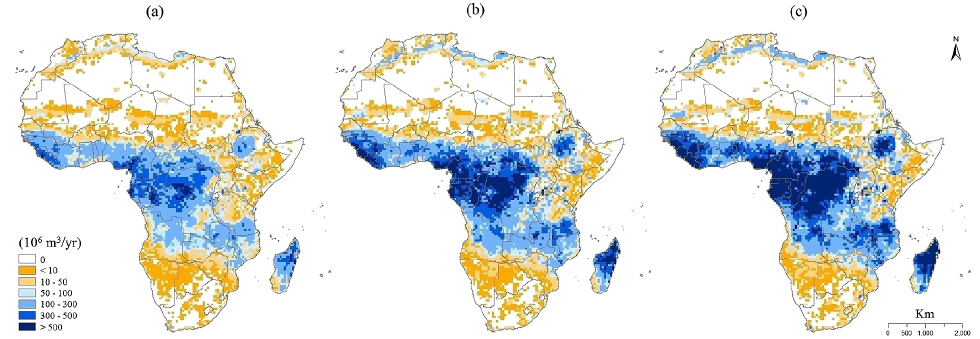
Figure 5. Average groundwater availability for irrigation (1960–2000), expressed in 10 6 m 3 year − 1 cell − 1 (0.5 ◦ × 0.5 ◦ ), for various levels of environmental groundwater requirements as a fraction of recharge: (a) Scenario 1: 70%, (b) Scenario 2: 50%, (c) Scenario 3: 30%.